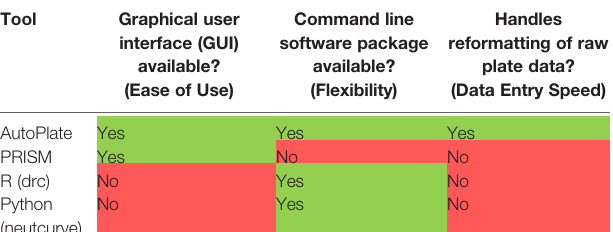
TABLE 1 | Qualitative comparison between AutoPlate and currently available software for analysing data from bioassays. Tool Graphical user interface